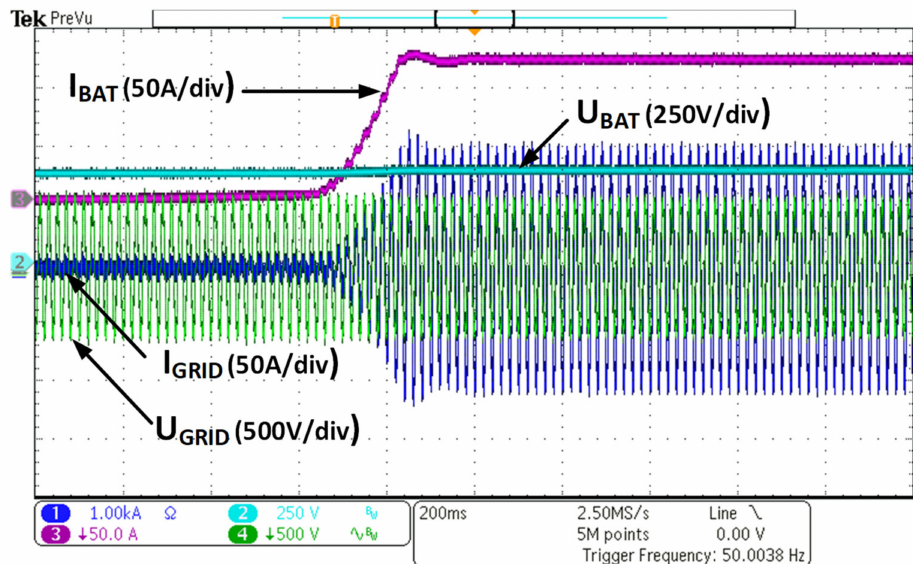
Figure 14. Operation of the unidirectional charger—step load change from 5% up to 80% of nominal power, from the top: battery current (purple), battery voltage (light blue), AC phase current (dark blue), AC line-to-line voltage